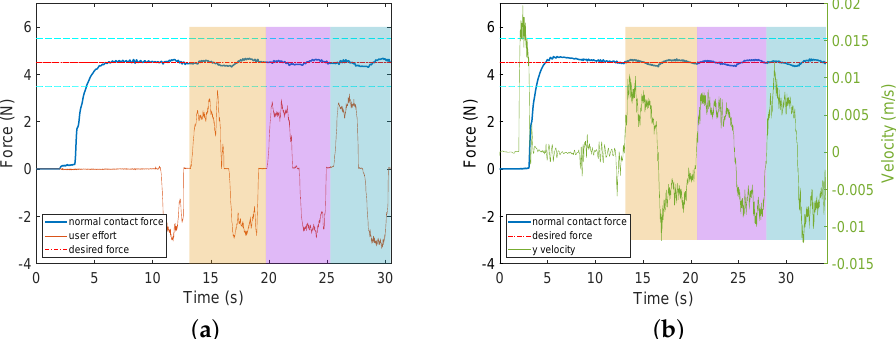
Figure 6. Sample data for US scanning on inclined slope tissue surface with different feedback are provided for two modes in Experiment 2b. AF means audio feedback; HF means haptic feedback; FC means force controller. Two horizontal dashed cyan lines define the tolerance area for the desired force. ( a ) AF + FC + HF ( p HRI mode). ( b ) AF + FC ( tele HRI